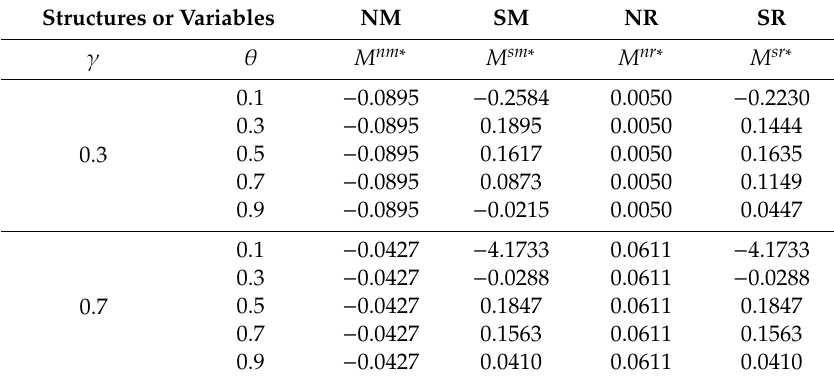
Table 6. The influence of sharing ratios on the profit of the manufacturer under four modes (Unit: USD). Structures or